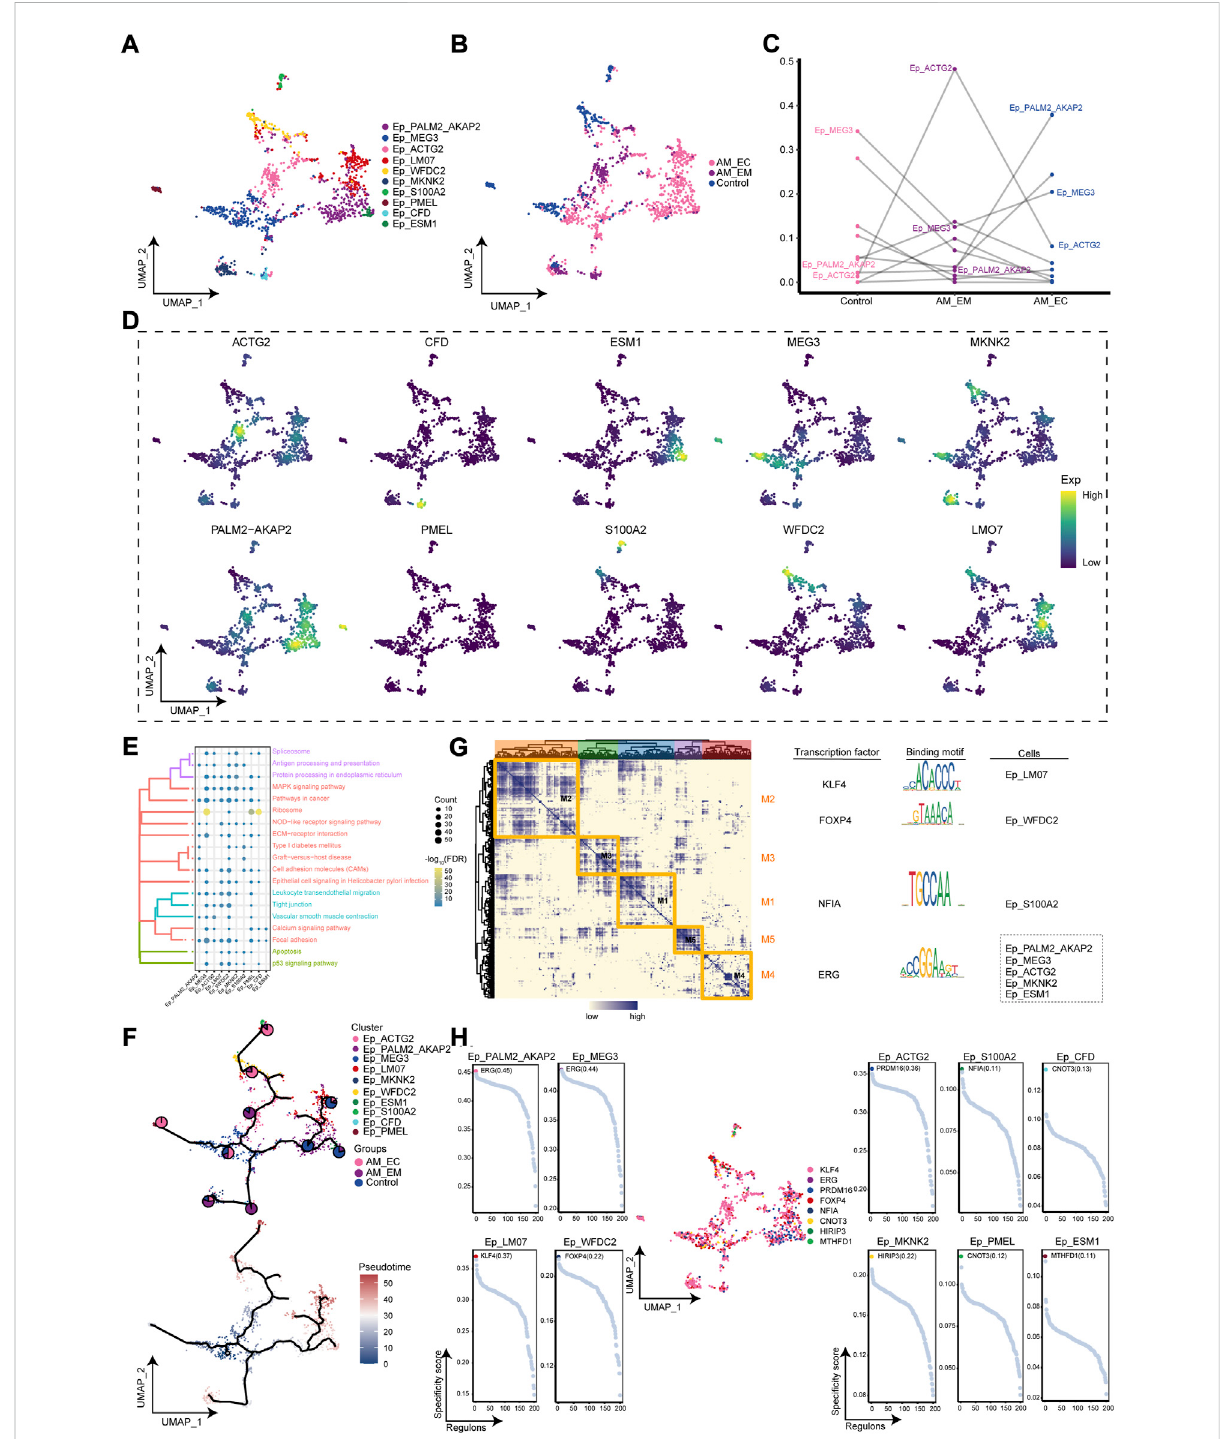
FIGURE 4 The adenomyosis (AM)-associated epithelial cell (Ep) clusters. (A) . Single-cell mapped of cell clusters of Ep. (B). Single-cell atlas shows the AM_EM, AM_EC, and control groups with clusters of Ep. (C). Differences in the cellular ecology of Ep clusters in different groups. (D). Marker genes forspeci fi cEpclusters. (E). BiologicalpathwaysinEpclusters. (F). Single-cellatlasmapthedevelopmental trajectory ofEpinAM.Piechartsshowthe proportionofthedifferentgroupsinthecluster. (G). TranscriptionfactorsofEpclustersinaco-expressionpattern.Left:Heatmapidenti fi edco- expression modules; Middle: major transcription factors and their binding sequences; Right: cell clusters of transcription factors. (H). Scatter plot of transcription factors in Ep clusters. AM_EM, eutopic endometrium; AM_EC, ectopic endometrium; UMAP, Uniform Manifold Approximation and